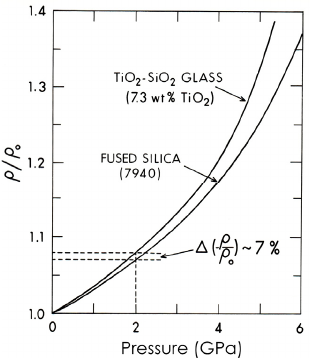
Figure 4. Comparison of the densification of fused silica and SiO 2 –TiO 2 glass containing 7.3 wt% TiO 2 up to 6 GPa using the Birch–Murnaghan equation of state. up to 6 GPa using the Birch–Murnaghan equation of